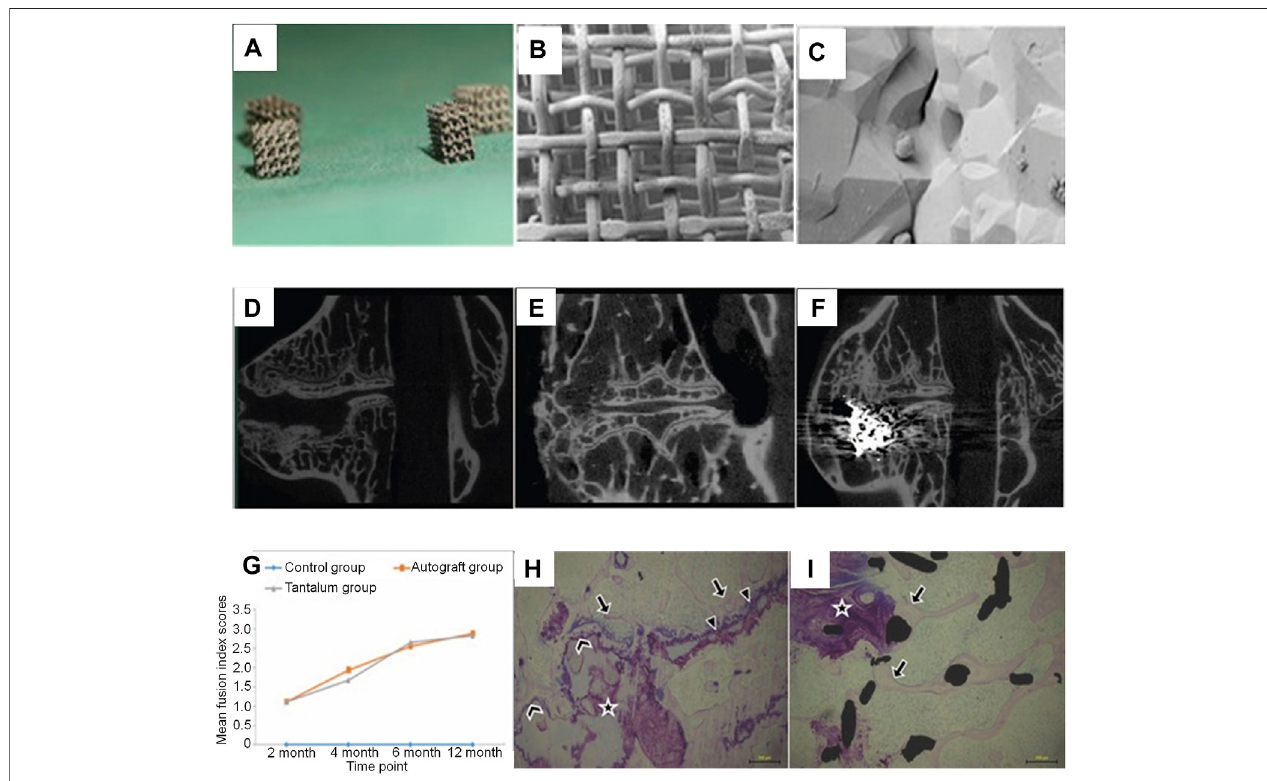
FIGURE 3 | (A – C) The outlook of cubic porous tantalum implants (whose length, width, and height are 2.5 – 3.0 mm). Scanning electron microscopic images of poroustantalumtakenatalowermagni fi cation(B;85×)andahighermagni fi cation(C;5,000×). (D – F) Micro-CTimagesofoperativelumbarintervertebralspacesinthe3 differentproceduresat12 monthspostoperatively: (D) discectomy-onlyspace(controlgroup), (E) discectomywithautologousboneimplantedspace(autograftgroup), and (F) discectomywithporoustantalumimplantedspace(tantalumgroup).Boththeautograftandtantalumgroupsdevelopedsolidfusionwithacontinuousbony bridge from the cranial to the caudal vertebra, while non-fusion was observed in the control group. (G) The imaging fusion index scores at different postoperative time points. Stained non-decalci fi ed sections showing new bone formation associated with osteonecrosis in the autograft (H) and porous tantalum interface (I) groups (Lu et al.,